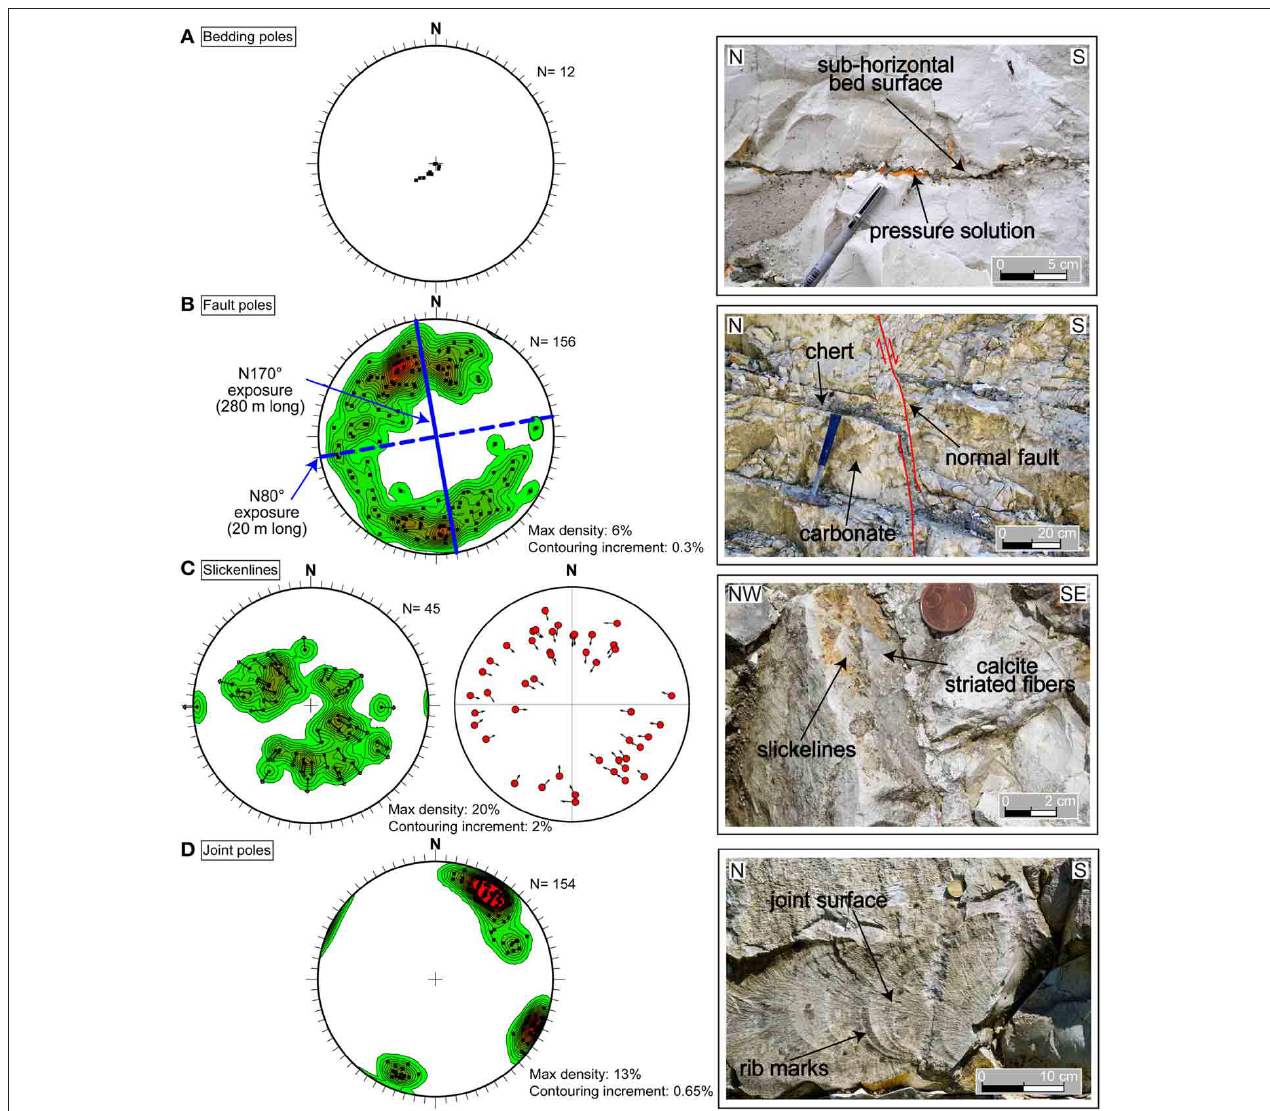
FIGURE 4 | Structure attitude data (left) plotted on Schmidt nets (lower hemisphere; produced with the Open Plot software by Tavani et al., 2011) and related photographic examples (right) from the study outcrop. (A) Poles to bedding (left) and example of stylolitic horizontal bedding surface (right). (B) Poles to faults and related density contour lines (left) with an example of fault affecting the carbonate and chert beds (right). (C) Fault slickenlines and related density contour lines (left plot) with an example of fault surface affected by both slickolites and striated calcite fibers (photograph). Fault slickenlines and related fault surfaces are also shown in the tangent lineation diagram (right plot; e.g., Hoeppener, 1955), where the arrows indicate the slip of the fault hangingwalls with respect to the related fault footwalls. In the diagram, the slip pattern is centripetal due to the poorly-systematic orientation of faults, over which the normal displacement is nearly-pure dip-slip. This tangent lineation diagram was produced with the Orient software by Vollmer (1995). (D) Poles to joints and related density contour lines (left) with an example of joint surface affected by typical rib marks (right).